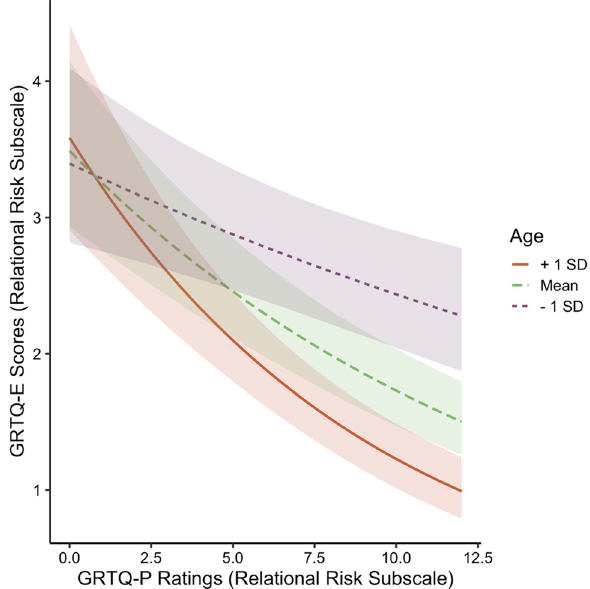
Figure 1. Follow-up simple slopes analysis for the interactions between age and the GRTQ-P Relational Risk ratings on the GRTQ-E Relational Risk scores. The shaded region depicts the 95% confidence level interval for the beta